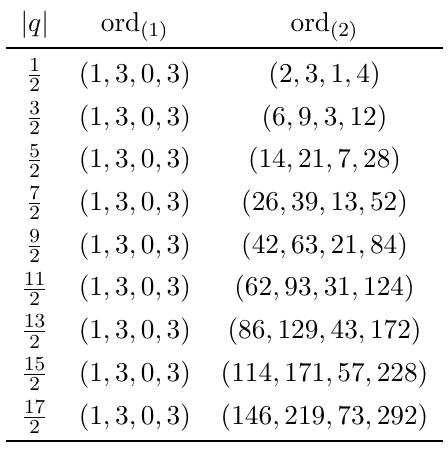
→ III ∗ enhancements. 2